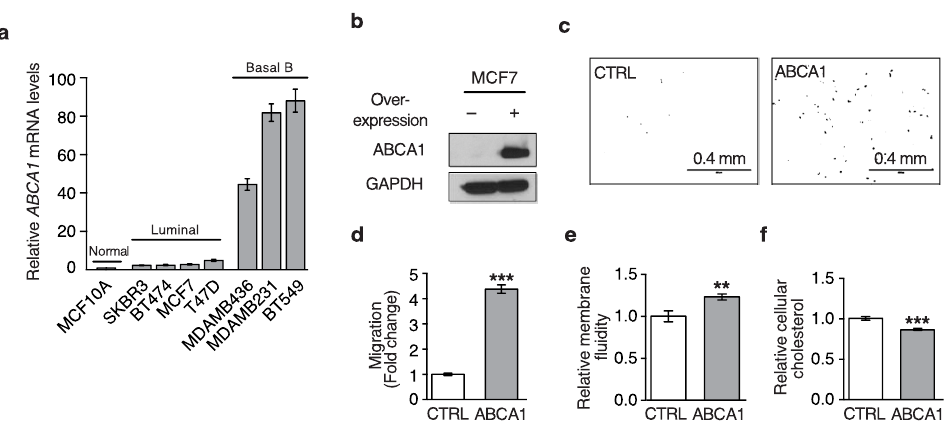
Figure 1. ABCA1 expression is higher in mesenchymal breast cancer cells and promotes migration in MCF7 cells. ( a ) Relative gene expression levels of ABCA1 are shown on the y -axis across breast cell lines. Normal indicates a non-cancer cell line, and Luminal and Basal B indicates the subtype of the cancer cell lines. Error bars indicate one standard deviation. ( b ) This immunoblot shows the expression of ABCA1 and GAPDH in MCF7 cells with or without overexpression of ABCA1. ( c ) A representative image (from 15 fields) shows the migrated MCF7 cells in from a transwell migration assay for the baseline condition ( left ) as well as those with ABCA1 expression ( right ). ( d ) The relative number of migrated cells are shown on the y -axis for the two conditions. Error bars indicate one standard deviation. Statistical significance, relative to the CTRL condition, is indicated by ** p < 0.01, *** p < 0.001. ( e ) The relative membrane fluidity is shown on the y -axis ( n = 3 technical replicates). Error bars indicate one standard deviation. ( f ) The relative cellular cholesterol content is shown on the y -axis ( n = 3 technical replicates). Error bars indicate one standard deviation. At least three biological replicates were performed for each experiment, and representative data are shown.